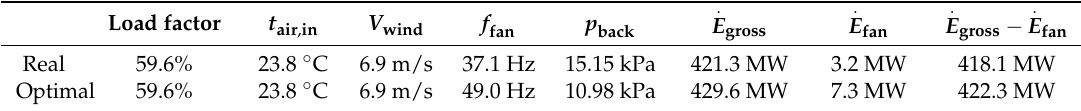
Table 1. A comparison between the real operation value and optimal value.